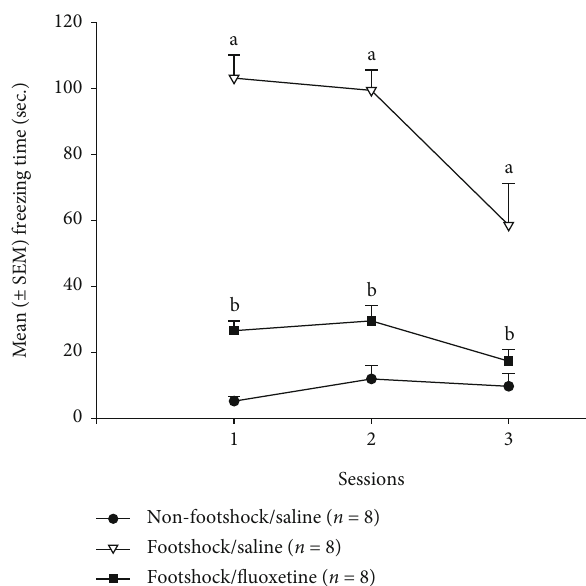
Figure 3: The mean ( ± SEM) fl oating time (sec.) in the forced swimming test for the nonfootshock/saline, footshock/saline, and footshock/ fl uoxetine groups ( n = 8 , per